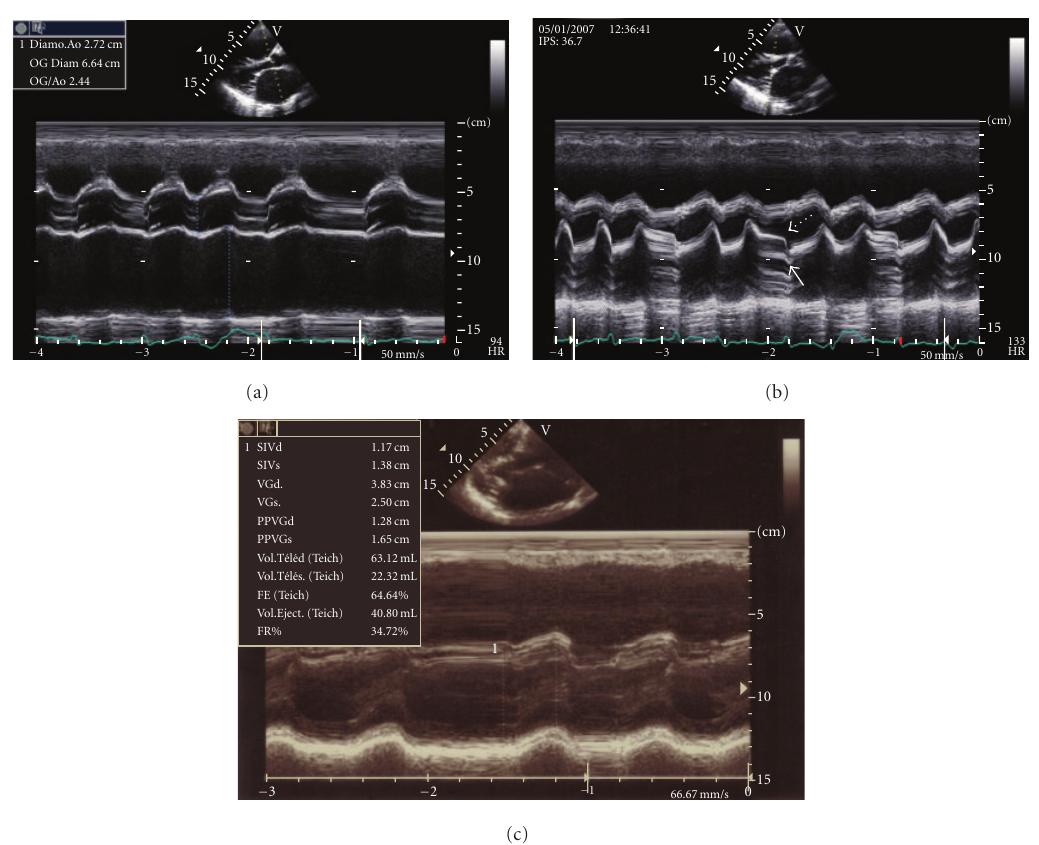
Figure 4: Transthoracic echocardiography, left parasternal long axis view M-mode. (a) dilatation of the left atrium. (b) Paradoxical anterior motion of posterior mitral leaflet (white arrow), with reduced separation of the two leaflets. Reduction of EF slope (broken arrow). (c) Normal left ventricular size, paradoxical septal